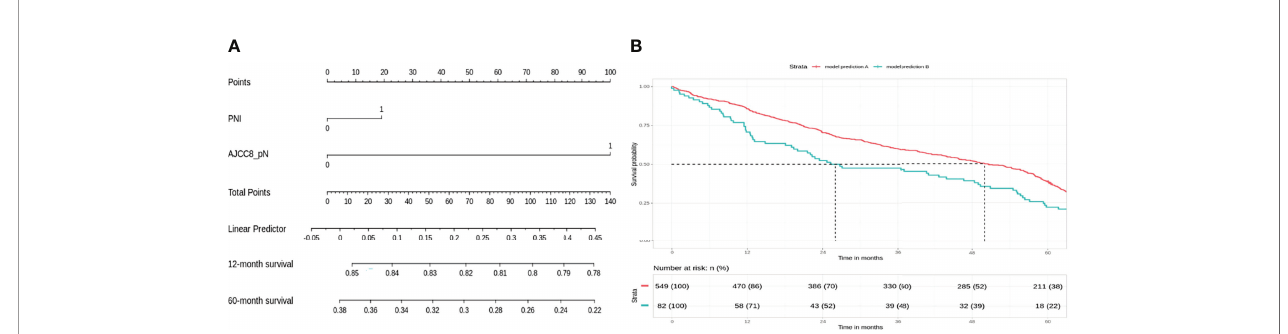
FIGURE 4 | High-risk group: margin, depth of invasion, and a composite score are signi fi cant negative prognostic indicators for overall survival (OS). (A) Nomogram model. (B) Internal validation: prediction of 5 ‐ year overall survival with nomogram model as compared to baseline (PR AUC = 0.925). Margin: 0, <5 mm from margin; 1, >5 mm from margin. Histologic differentiation: G1, well differentiated (1); G2, moderately differentiated (2); G3, poorly differentiated (3). PNI, perineural invasion; PR AUC, precision – recall area under